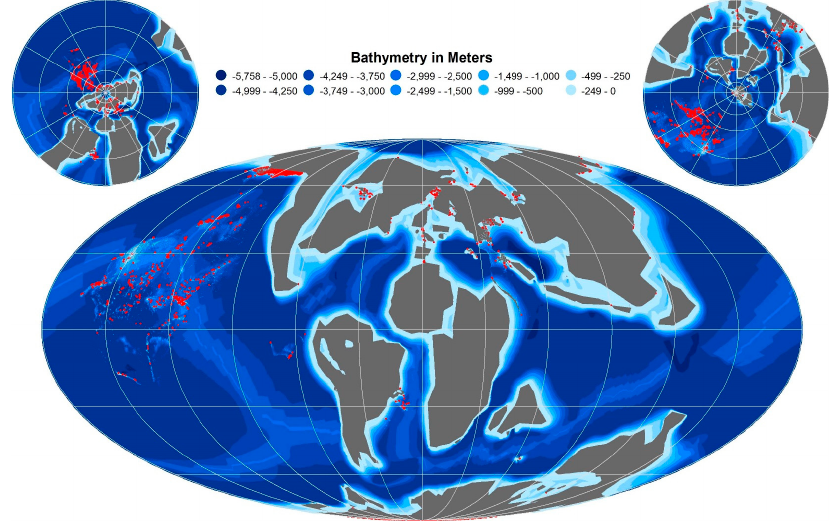
Figure 9. Distribution of the interpolated points (in red) on top of the interpolated 94 Ma reconstructed bathymetry with isostatically adjusted, multicomponent sediment layer, continental shelf-slope-rise structures, and known LIPs and seamounts.